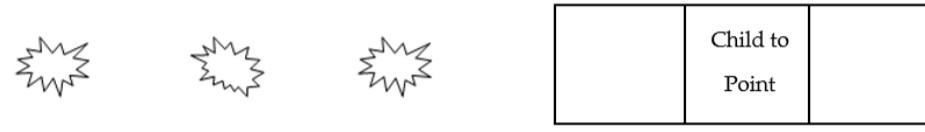
Figure 1. Example of ‘Odd One Out’ Card and Response